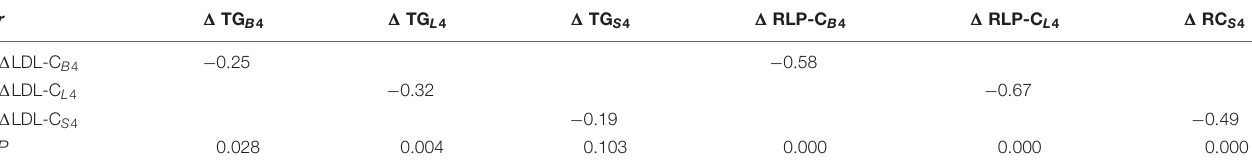
TABLE 2 | Correlation coefficients between absolute change in LDL-C level (mmol/L) and those in TG and RC levels (mmol/L) after each meal.